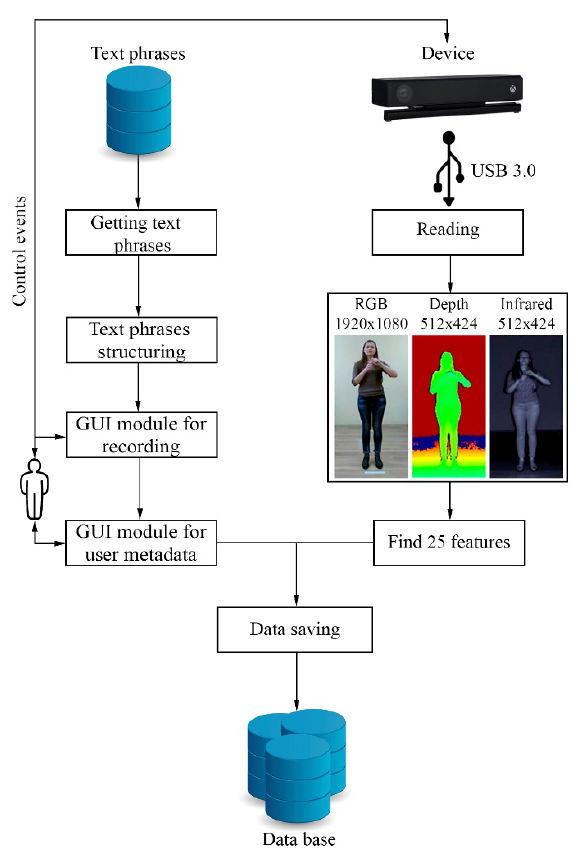
Figure 2. The logical structure of the modules of the MulGesRecDB system for recording a 3D gestural database